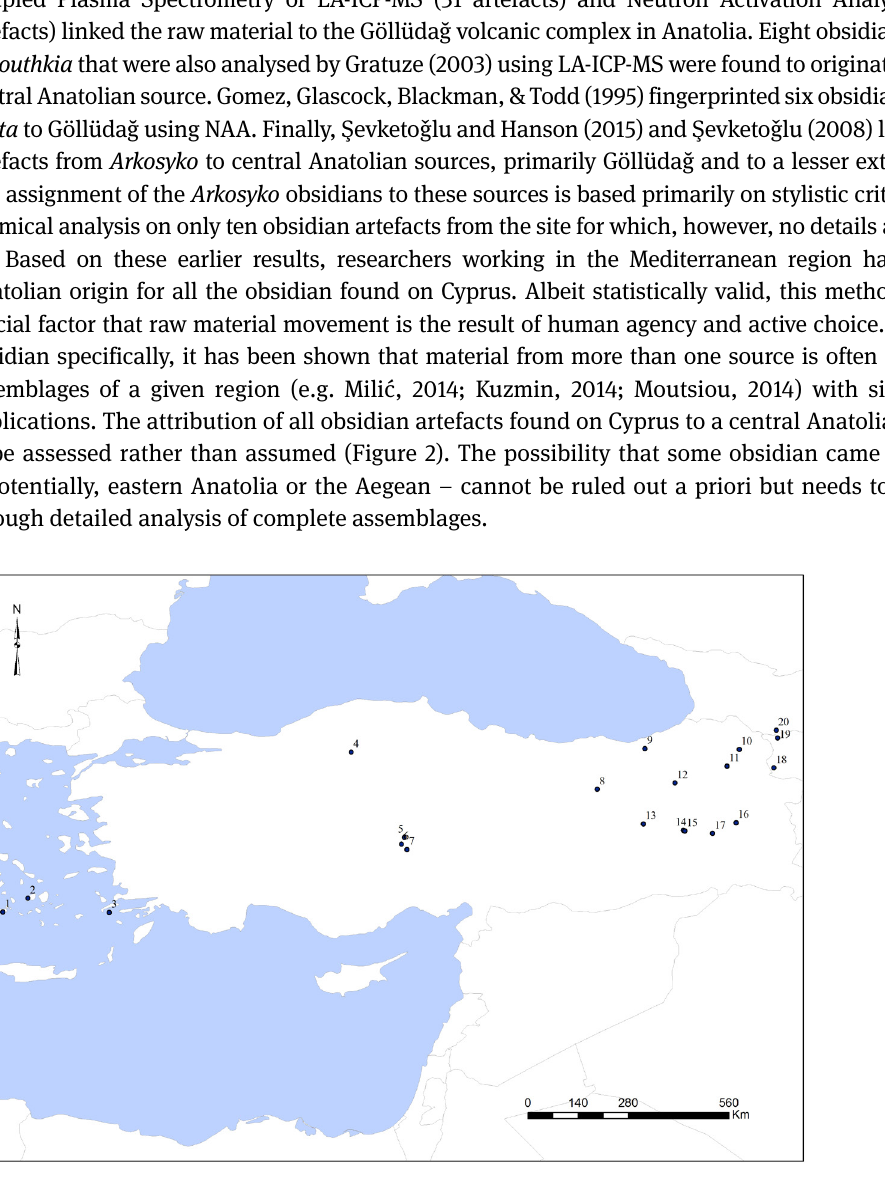
Figure 2. Map showing the location of the main geological sources of obsidian in the eastern Mediterranean region neighbou- ring the island of Cyprus. [Note: 1=Melos, 2=Antiparos, 3=Giali, 4=Sakaeli, 5=Acigöl, 6=Nenezi Dag, 7= Göllüdağ, 8=Erzin- can, 9=Ikizdere, 10=Kars, 11=Sarikamis, 12=Erzurum, 13=Bingöl, 14=Mus, 15=Meydan Dag, 16=Suphan Dag, 17=Nemrut Dag, 18=Arteni, 19=Ashotsk, 20=Chikiani]. Map generated by the author. 1 See online Supplementary